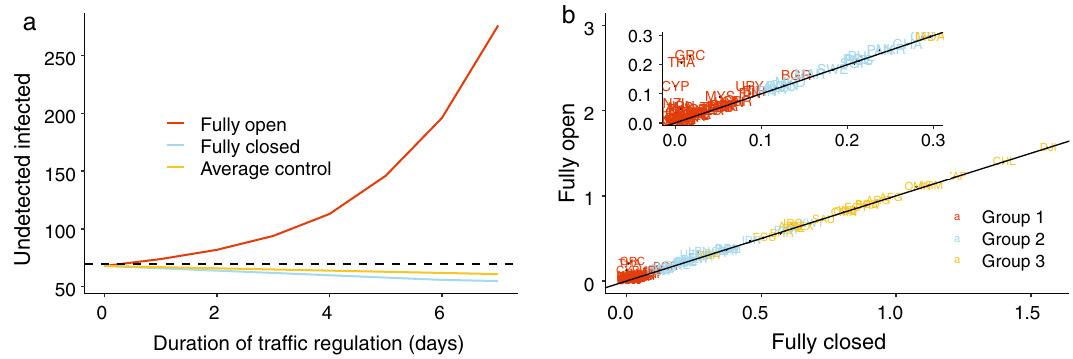
Figure 3. ( a ) Prediction of the average number of undetected infected cases for different travel regulation policies. “Fully open” indicates no travel restrictions are in place, “Fully closed” indicates no travel is permitted, and “Average control” denotes our proposed policy whereby the number of daily undetected infected cases should stay below a threshold of c = 70 (the dashed line) on average. ( b ) Scatter plot for the relative change in the total number of new cases for each country in the two most extreme scenarios, fully closed and fully open for the first two weeks of June 2020. The 97.5th percentile value of relative change in each country’s number of new cases under the “Fully closed” scenario (x-axis) is plotted versus the corresponding number for the “Fully open” scenario (y-axis). The closer a country is to the reference line x = y , the less benefit that country gains from travel